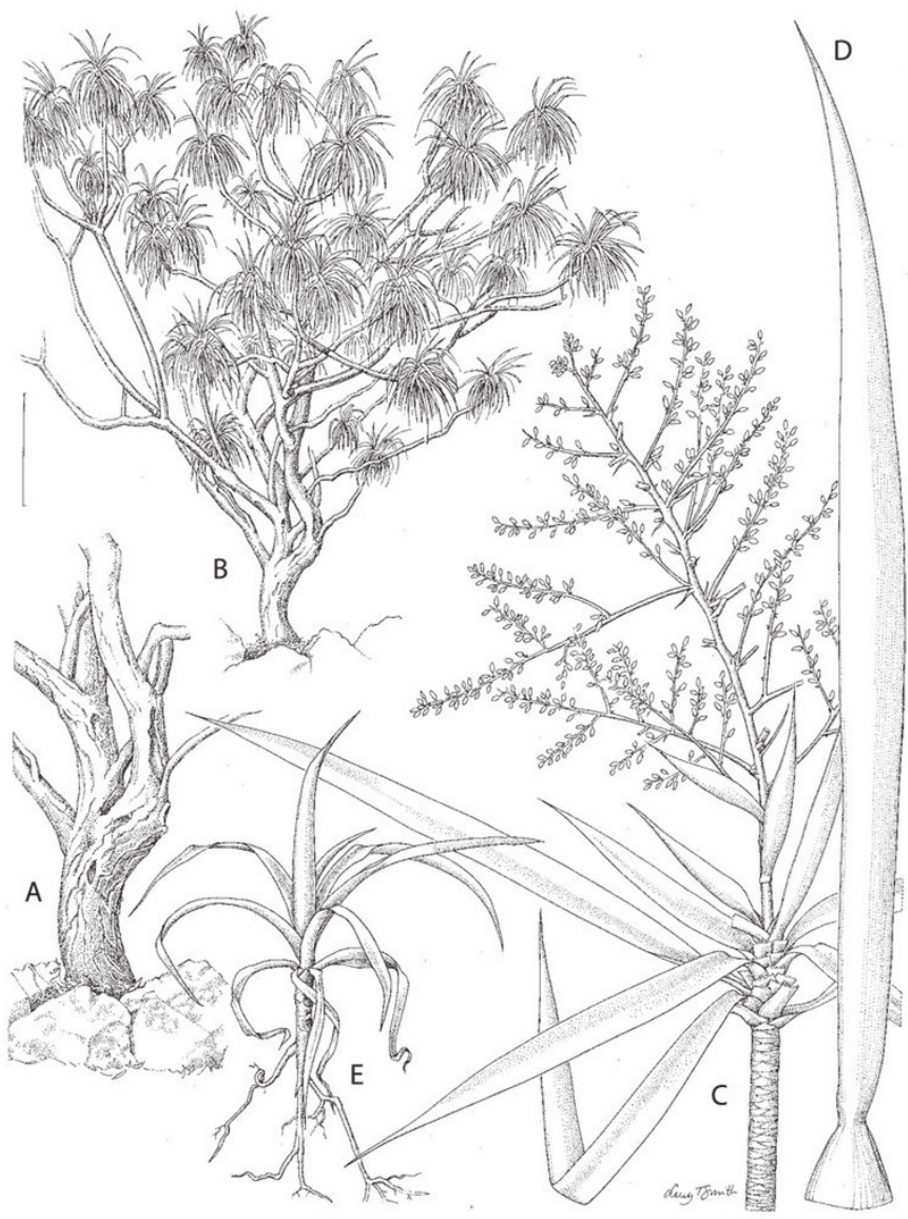
Figure 1. The habit, vegetative, inflorescence and seedling of Dracaena kaweesakii . A Trunk base showing the pattern of branching and corky, fissured surface B Habit C Branch apex with erect in- florescence D Leaf sheath and blade E Seedling with rosulate leaves. Scale bar: A 50 cm; B 125 cm; C 6 cm; D 3 cm; E 4 cm. From Maxwell 96-379 ( C ), Geesink et al. 8122 ( D ) and photographs. Drawn by Lucy